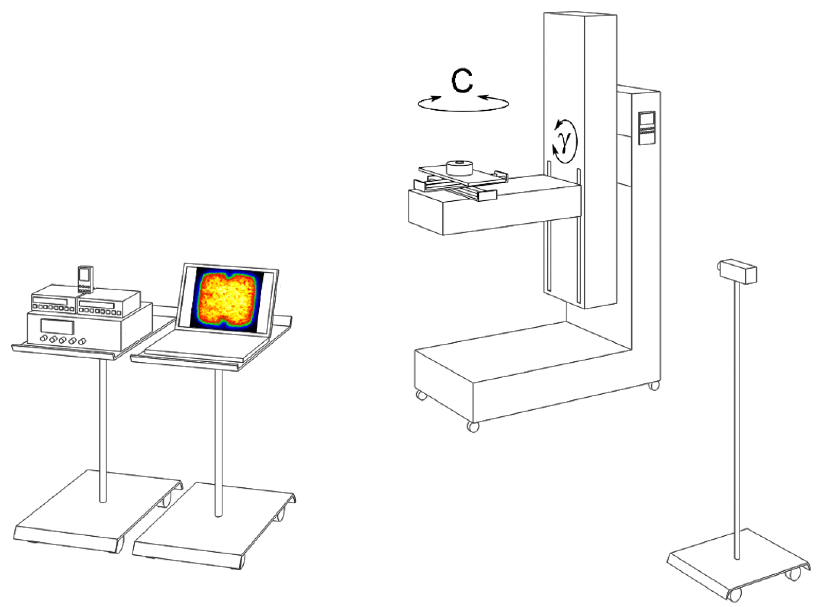
Figure 5. The measuring set-up for luminance measurements above 1 m. The measuring set-up presented in Figure 5 was used for distances above 1 m. Before each measurement, the diodes were illuminated until thermal stability was reached, which was monitored during the